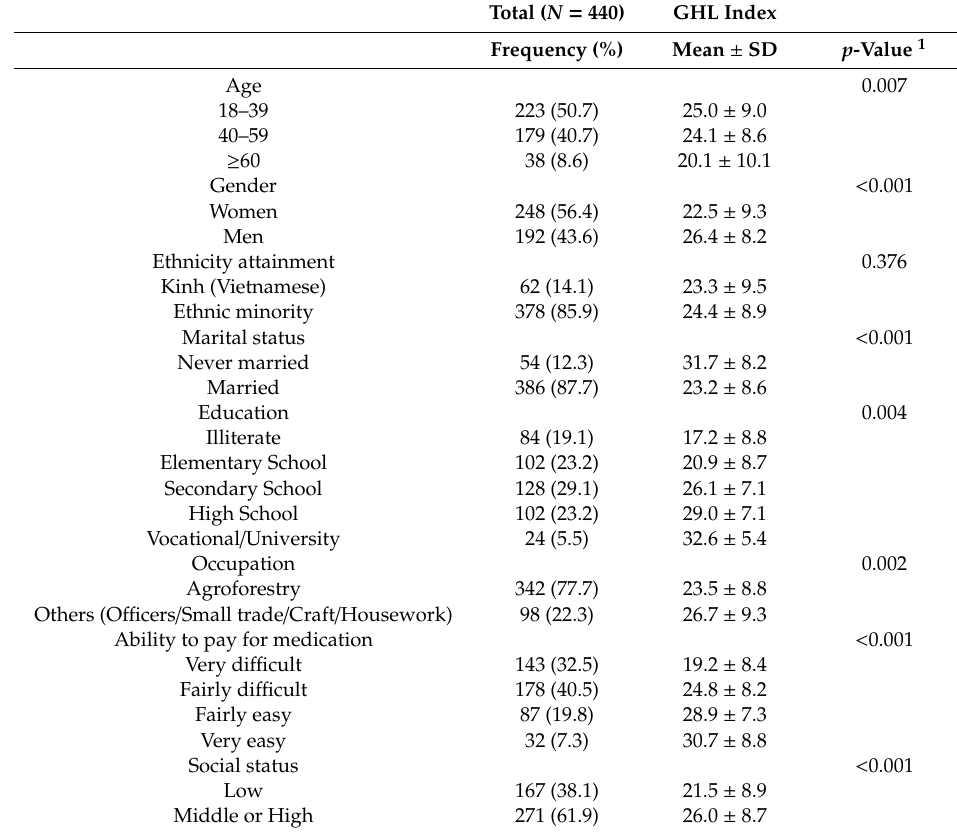
Table 1. Characteristics and health literacy index score of